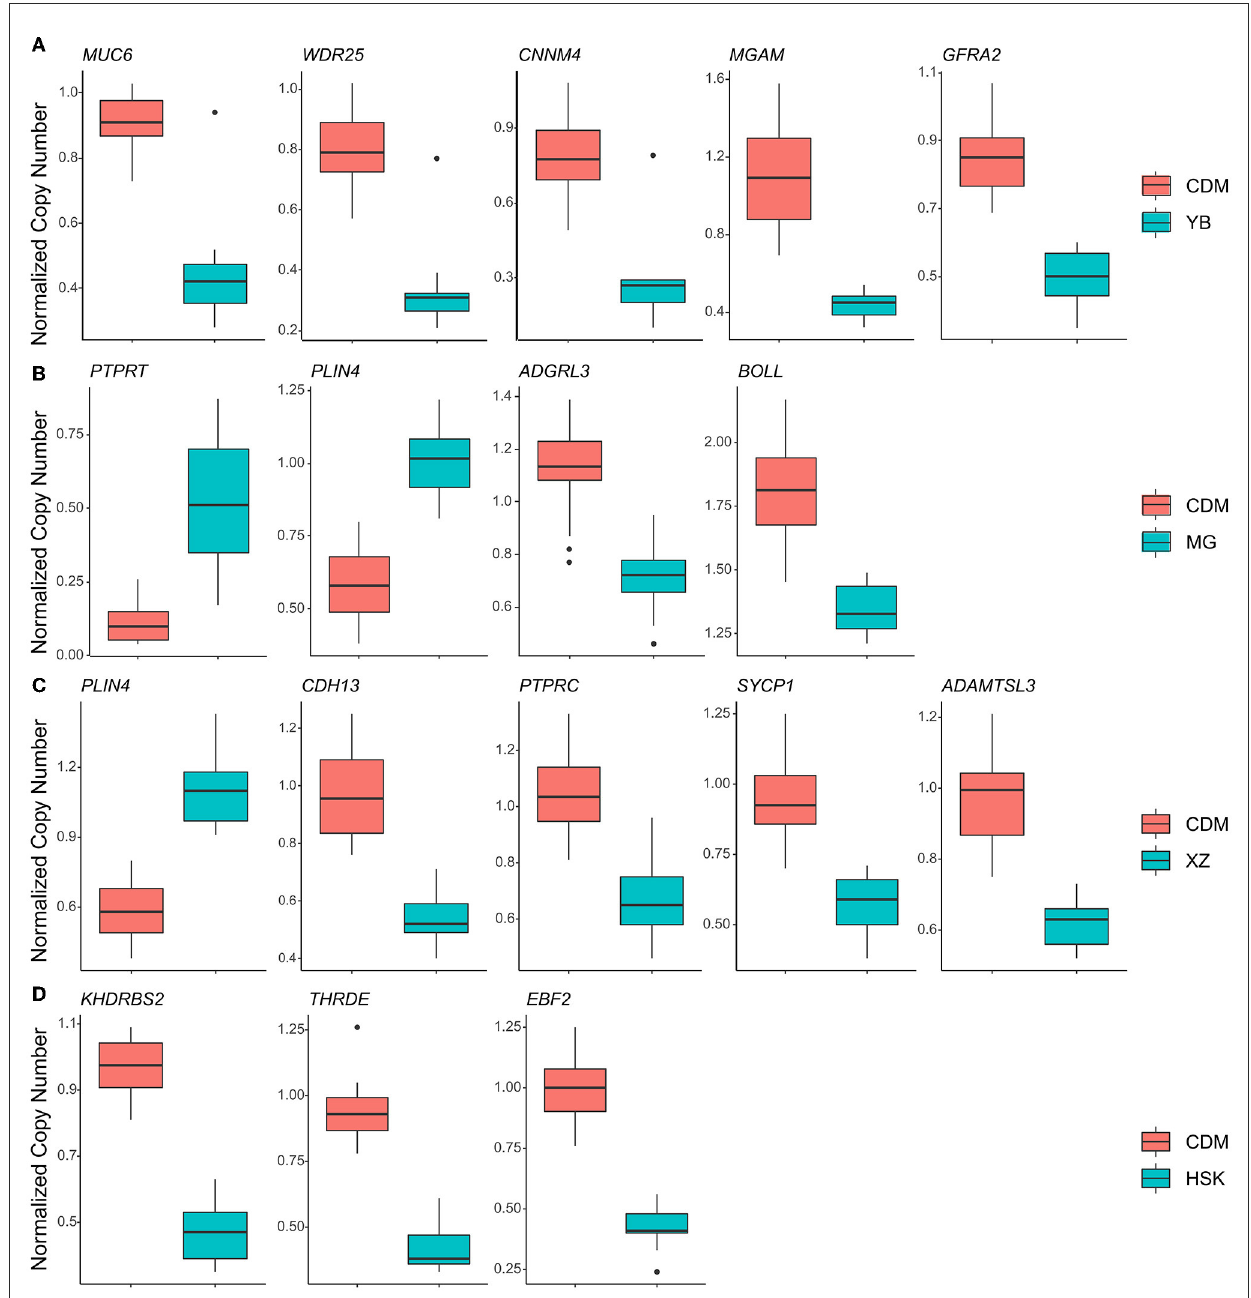
FIGURE4 Normalized copy number comparison of the top 1% V ST genes between CDM and other populations. (A) CDM compared with the YB population. (B) CDM compared with the MG population. (C) CDM compared with the XZ population. (D) CDM compared with the HSK